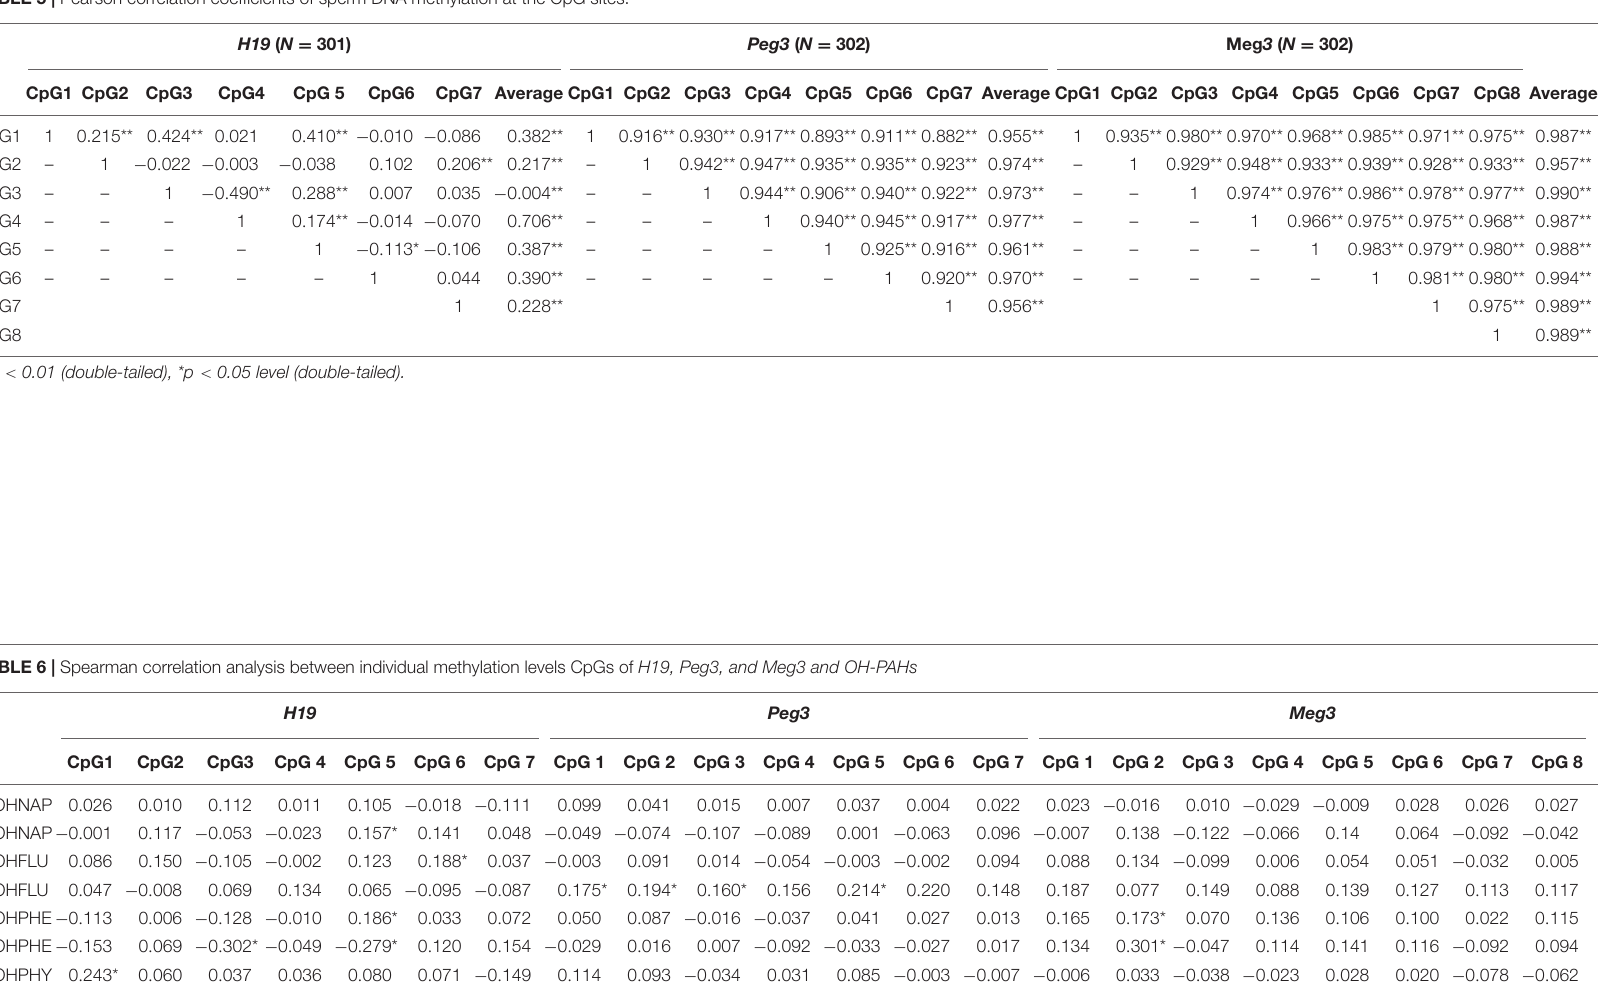
TABLE 5 | Pearson correlation coefficients of sperm DNA methylation at the CpG sites.